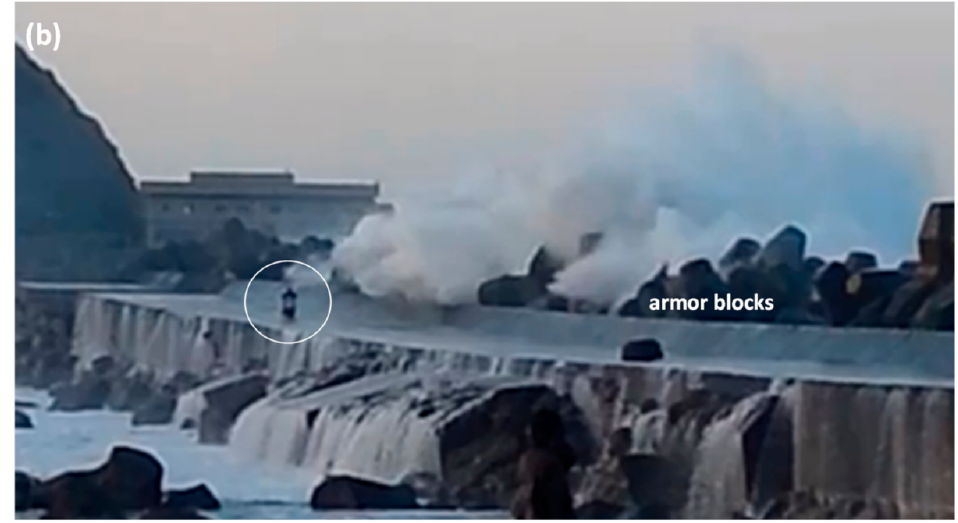
Figure 1. ( a ) Location of the coastal freak wave (CFW) occurrence in northern Taiwan; ( b ) Snapshot of the CFW accident. The scooter rider (white circle) was hit by the CFW and swept into the sea.